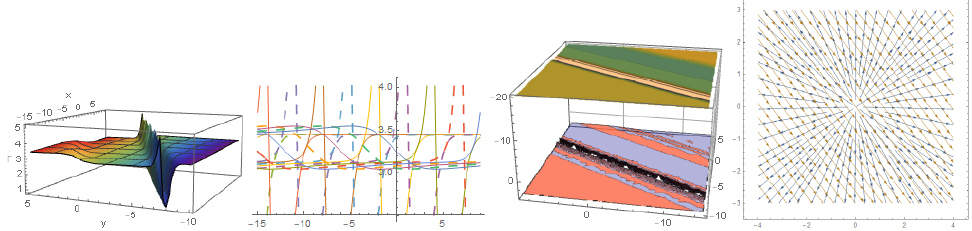
Figure 13. Multi-wave dynamical behavior via l 1 = 4, η = 1, c = 1, ρ = 3, l 0 = 2, m 2 = 3, m 6 = 2, λ = 1.2, δ = 2, l 2 = 12, t = 9, and m 4 =